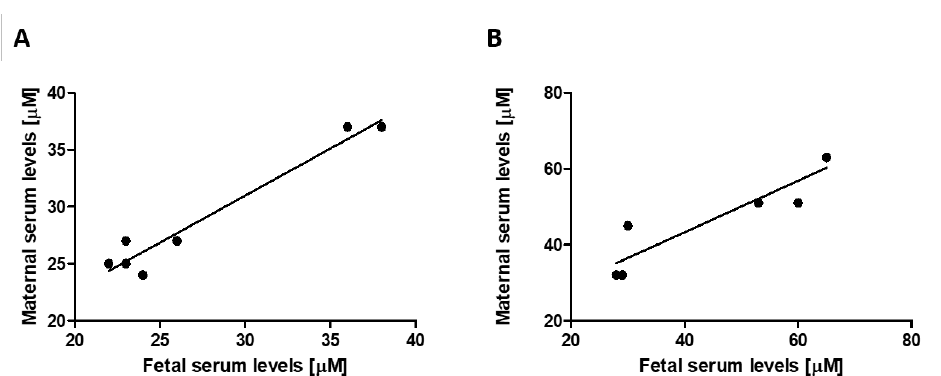
Figure 2. Correlation between maternal and (wild-type) fetal uric acid levels: ( A ) normal diet, and ( B ) diet with inosine supplementation.